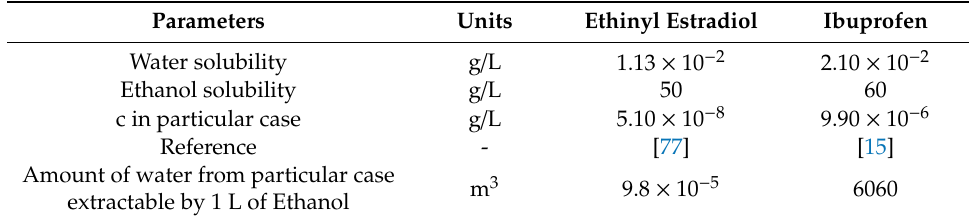
Table 5. Illustration of vast di ff erences between the solubility of ECs (ethinyl estradiol and ibuprofen) in water and